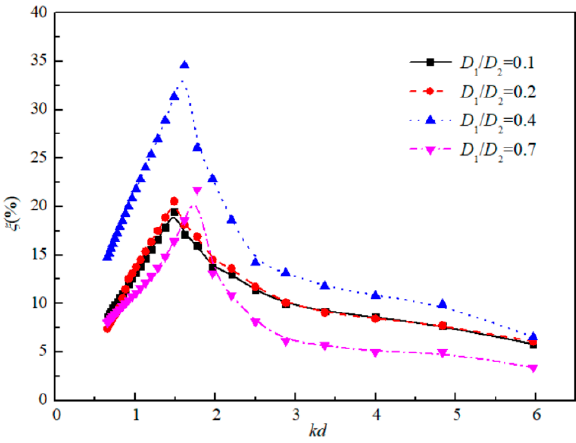
Figure 9. E ff ects of cylinder diameter D 1 / D 2 on power extraction e ffi ciency with di ff erent